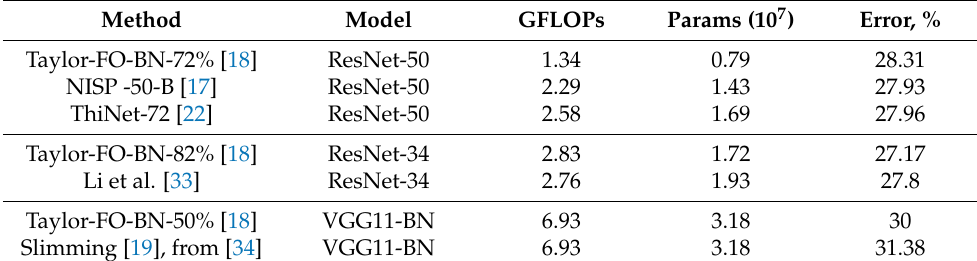
Table 2. Classification results evaluate existing cutting methods.